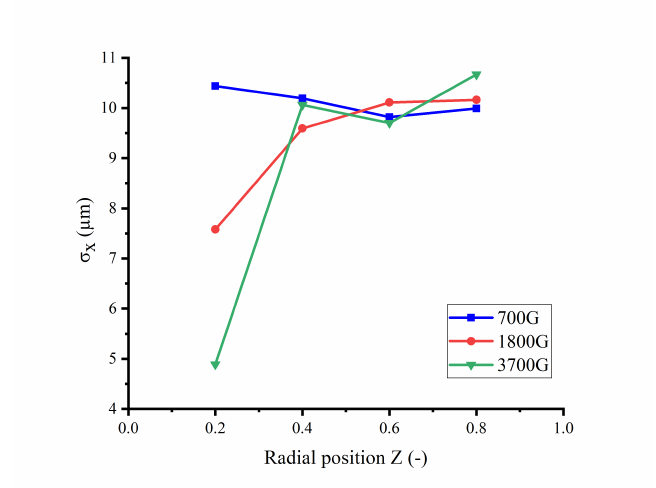
Figure 9. Standard deviation of equivalent particle diameters versus radial position.